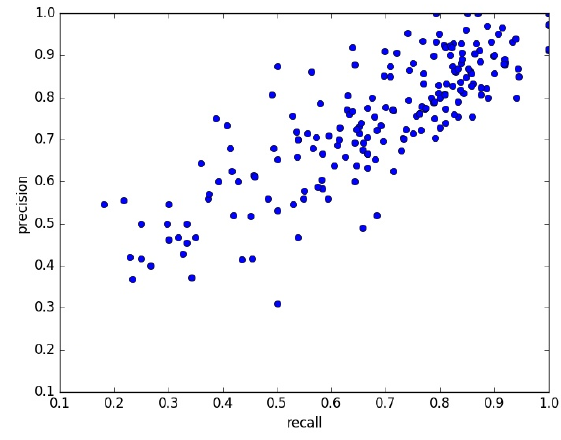
Figure 4. Mean (by request) precision and recall (for fixed threshold) for different classes. Each point represent one of 200 seen classes